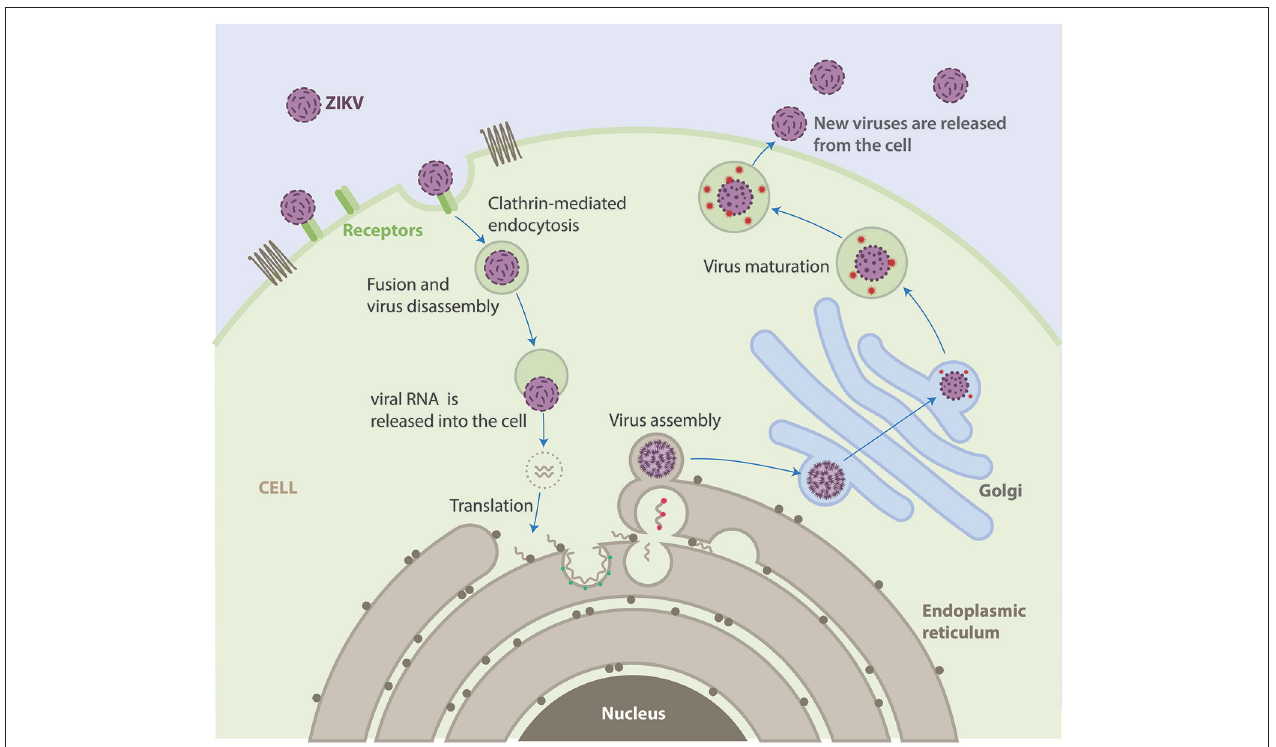
FIGURE 2 | Life cycle of ZIKV. ZIKV attaches to the surface of a host cell and enters the cell by a process called endocytosis. Once deep inside the cell, the virus fuses with the endosomal membrane and it is released into the cytoplasm. The virus particle releases the viral genome. The viral RNA is translated into a single polypeptide that is cut into 10 proteins, and the viral genome is replicated. Virus assembly occurs on the surface of the endoplasmic reticulum. The immature viral particles are transported through the trans-Golgi network, where they mature and convert to their infectious form. The mature viruses are released from the cell and can go on to infect other